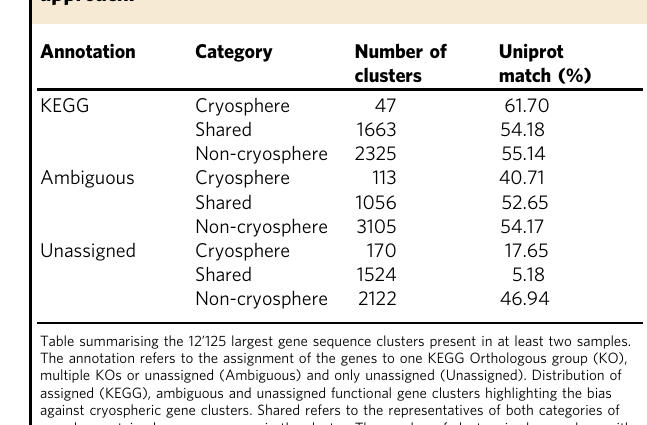
Table. 1 Description of the gene sequences clustering approach.